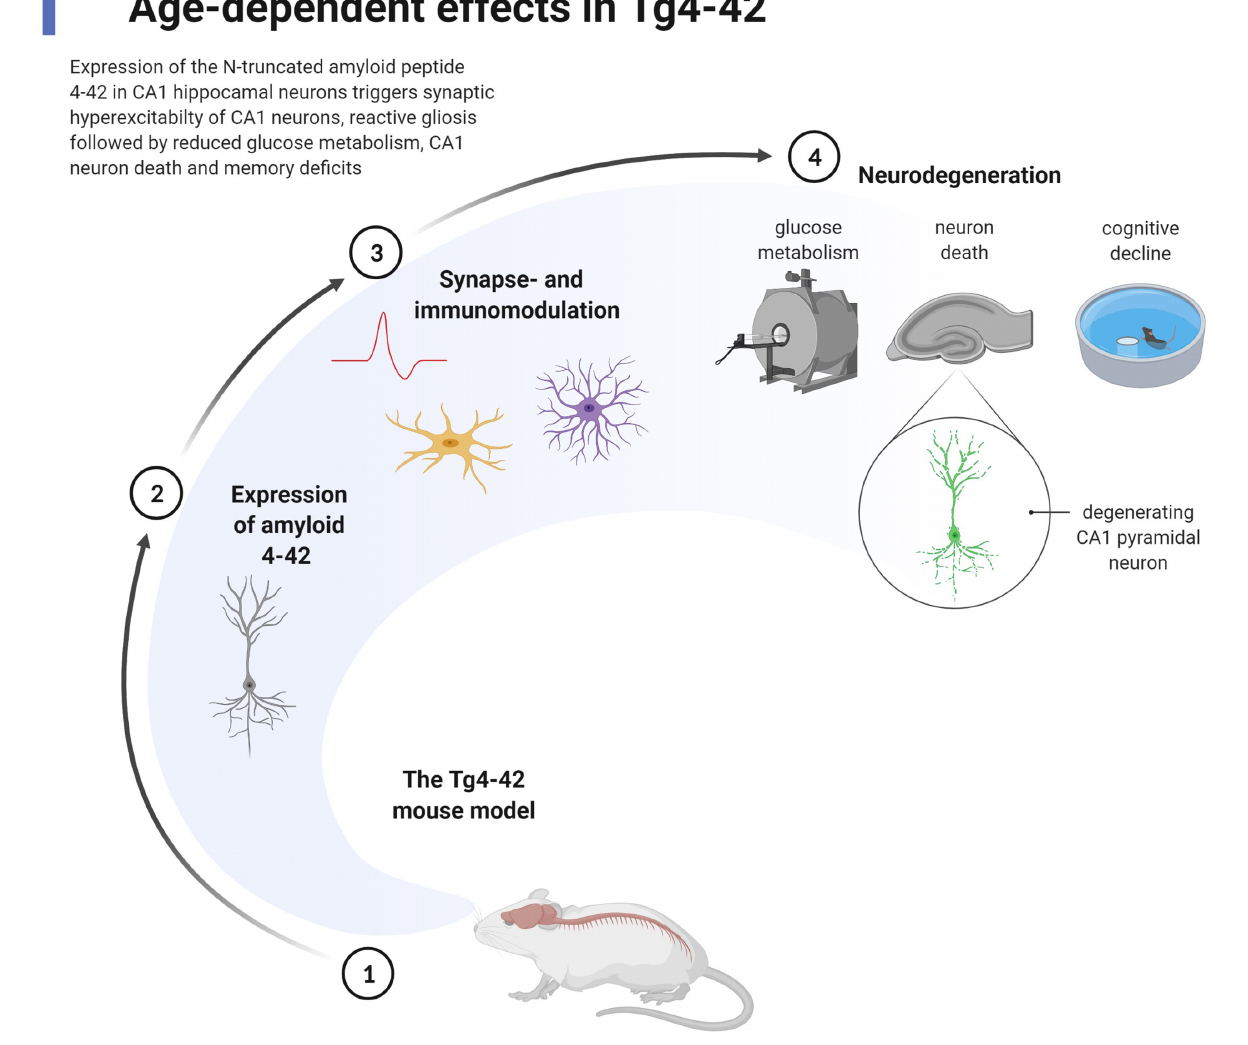
FIGURE 2 | Chronic effect of the expression of A β 4–42 in the Tg4–42 mouse model for Alzheimer’s disease (AD). The transgenic mouse model Tg4–42 (1) expresses exclusively normal wildtype human A β 4–42 predominantly in pyramidal neurons in the CA1 area of the hippocampus (2). The expression of A β 4–42 induces early (starting at 2–3 months of age) pathological effects highlighted by synaptic hyperexcitability of CA1 pyramidal neurons, reactive micro- and astroglia (3). As a consequence of chronic exposure of A β 4–42 (4), massive reduction in glucose metabolism is detected by 18 F-PET/magnetic resonance imaging (MRI), loss of degenerating CA1 pyramidal neurons, and loss of spatial reference memory analyzed by the Morris water maze test (starting at 4–6 months of age). The figure shows methodologies in addition to pathological events using appropriate symbols. Created with